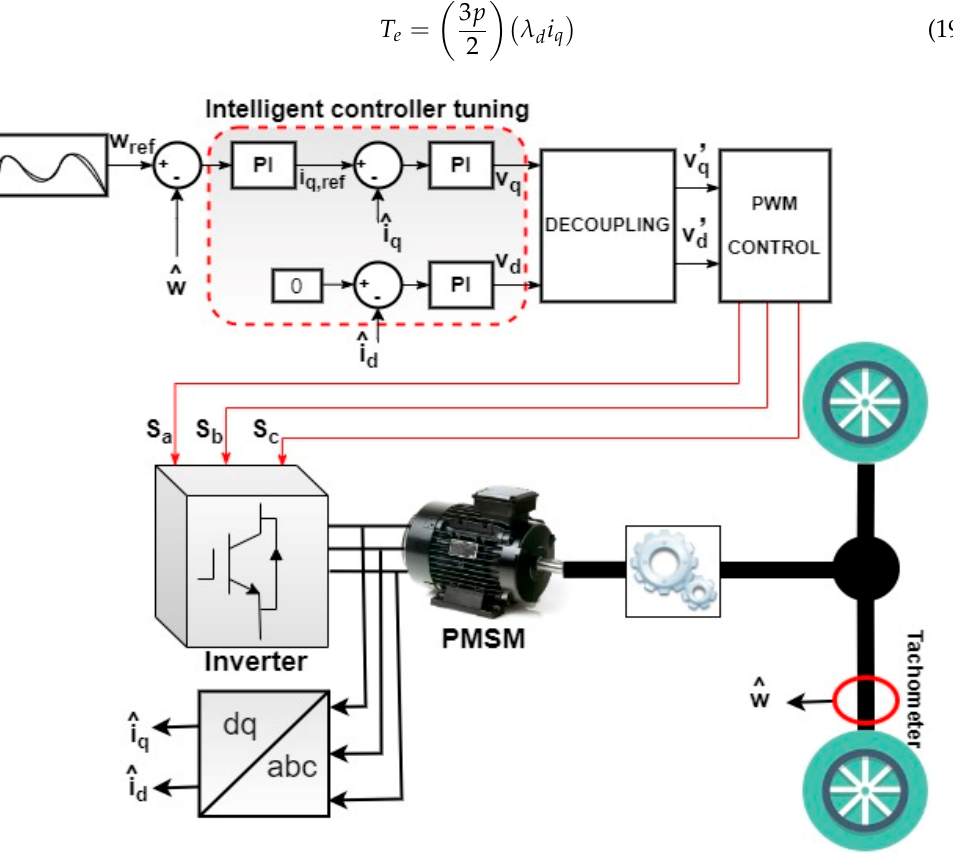
Figure 4. Electric vehicle field oriented controlled scheme.